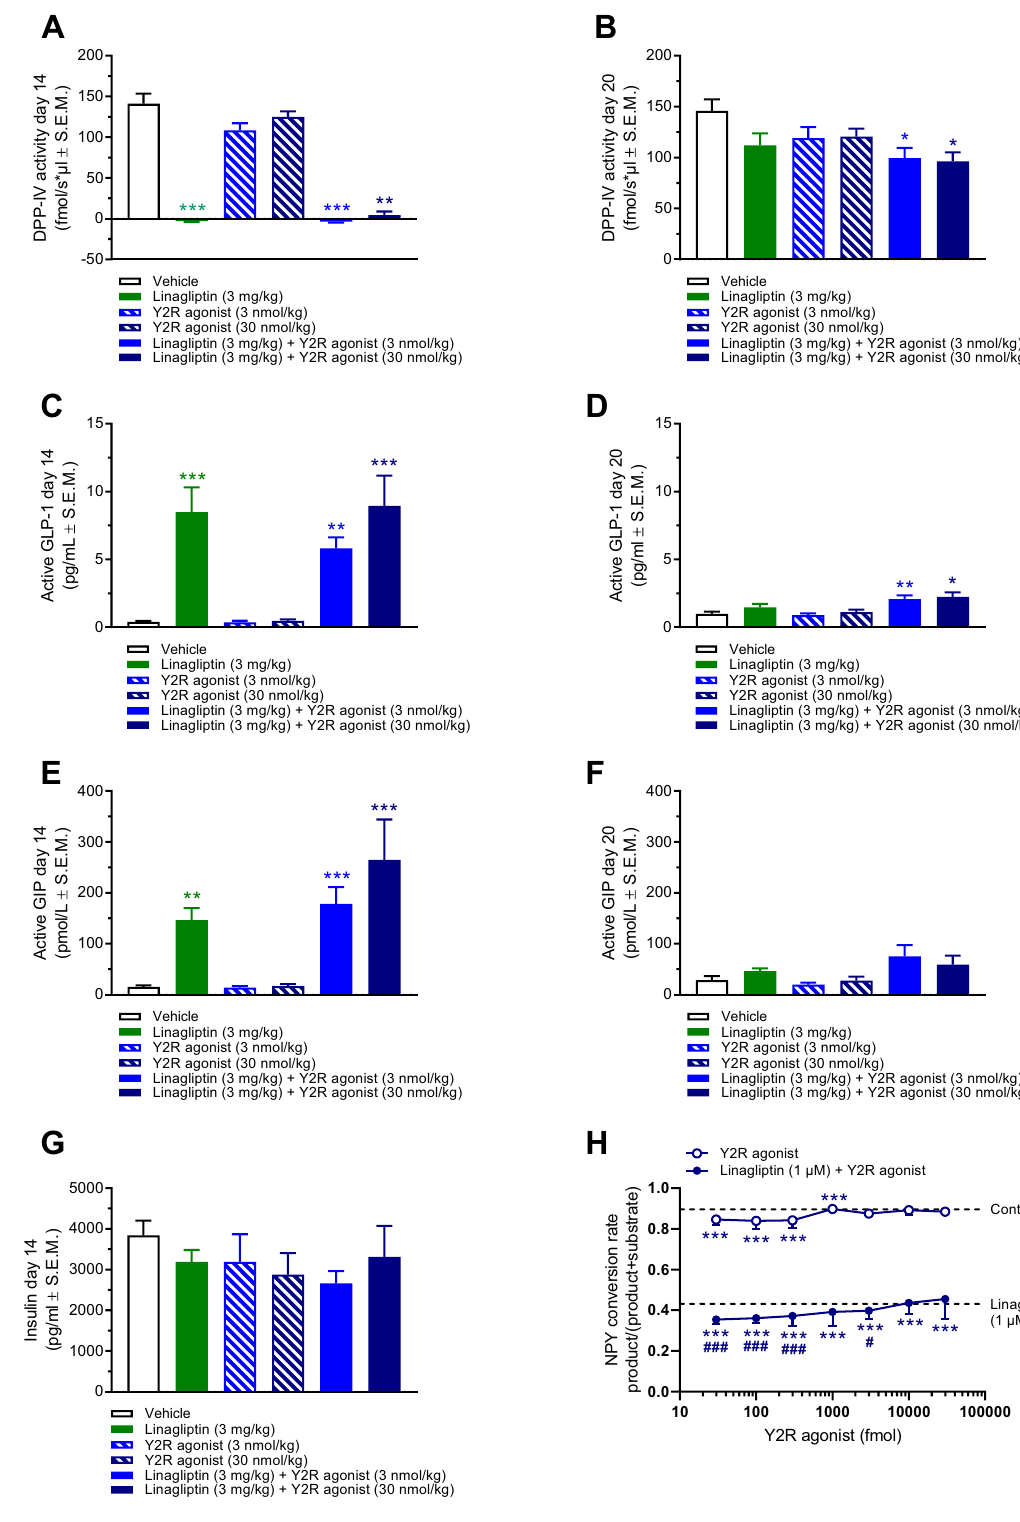
Figure 6. Linagliptin-induced DPP-IV inhibition is unaffected by Y2R agonist co-administration. Linagliptin (3 mg/kg, SC) and long- acting Y2 receptor agonist (PYY analogue, 3 or 3 nmol/kg, SC) was administered once daily for 14 days followed by 6 days of wash-out (no treatment) before study termination. (A) Plasma DPP-IV activity measured on treatment day 14 (4 h post-dosing). (B) Terminal plasma DPP-IV activity measured on study day 20. (C) Plasma active GLP-1 levels measured on treatment day 14 (4 h post-dosing). (D) Terminal plasma active GLP-1 levels measured on study day 20. (E) Plasma active GIP levels measured on treatment day 14 (4 h post-dosing). (F) Terminal plasma active GIP levels measured on study day 20. *p < 0.05, **p < 0.01, ***p < 0.001 vs. vehicle control (Kruskal–Wallis test). (G) Plasma insulin levels measured on treatment day 14 (4 h post-dosing). (H) NPY conversion rate in human EDTA-plasma added linagliptin (1 µM), Y2 receptor agonist (30–30,000 fmol) or linagliptin (1 µM) + Y2R agonist (30–30,000